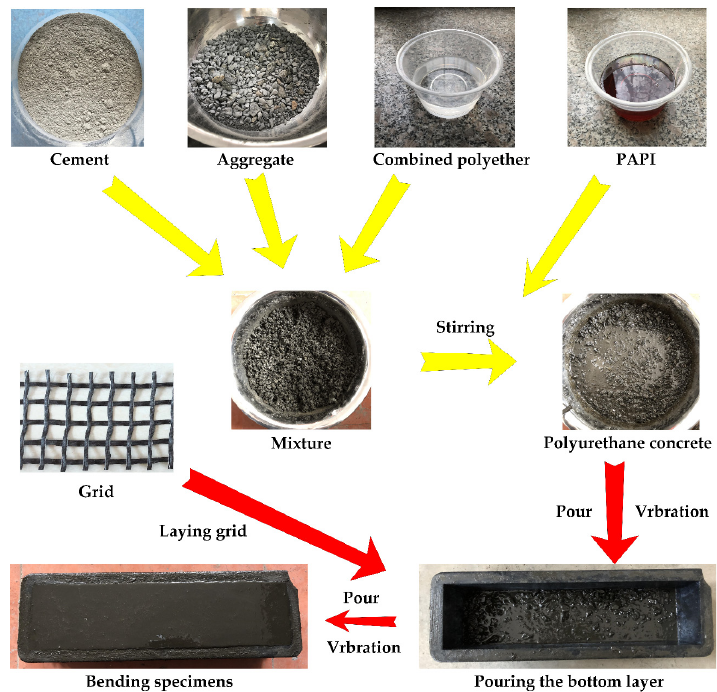
Figure 6. Fabrication process of the bending test piece.